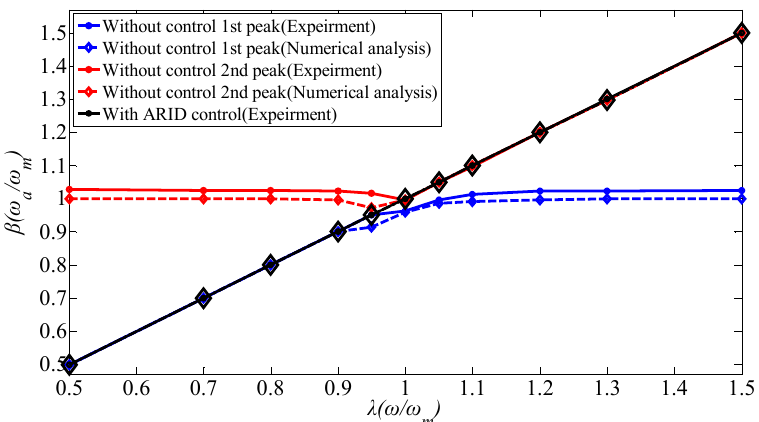
Figure 11. Frequency domain analysis diagram of the experiment and numerical analysis.